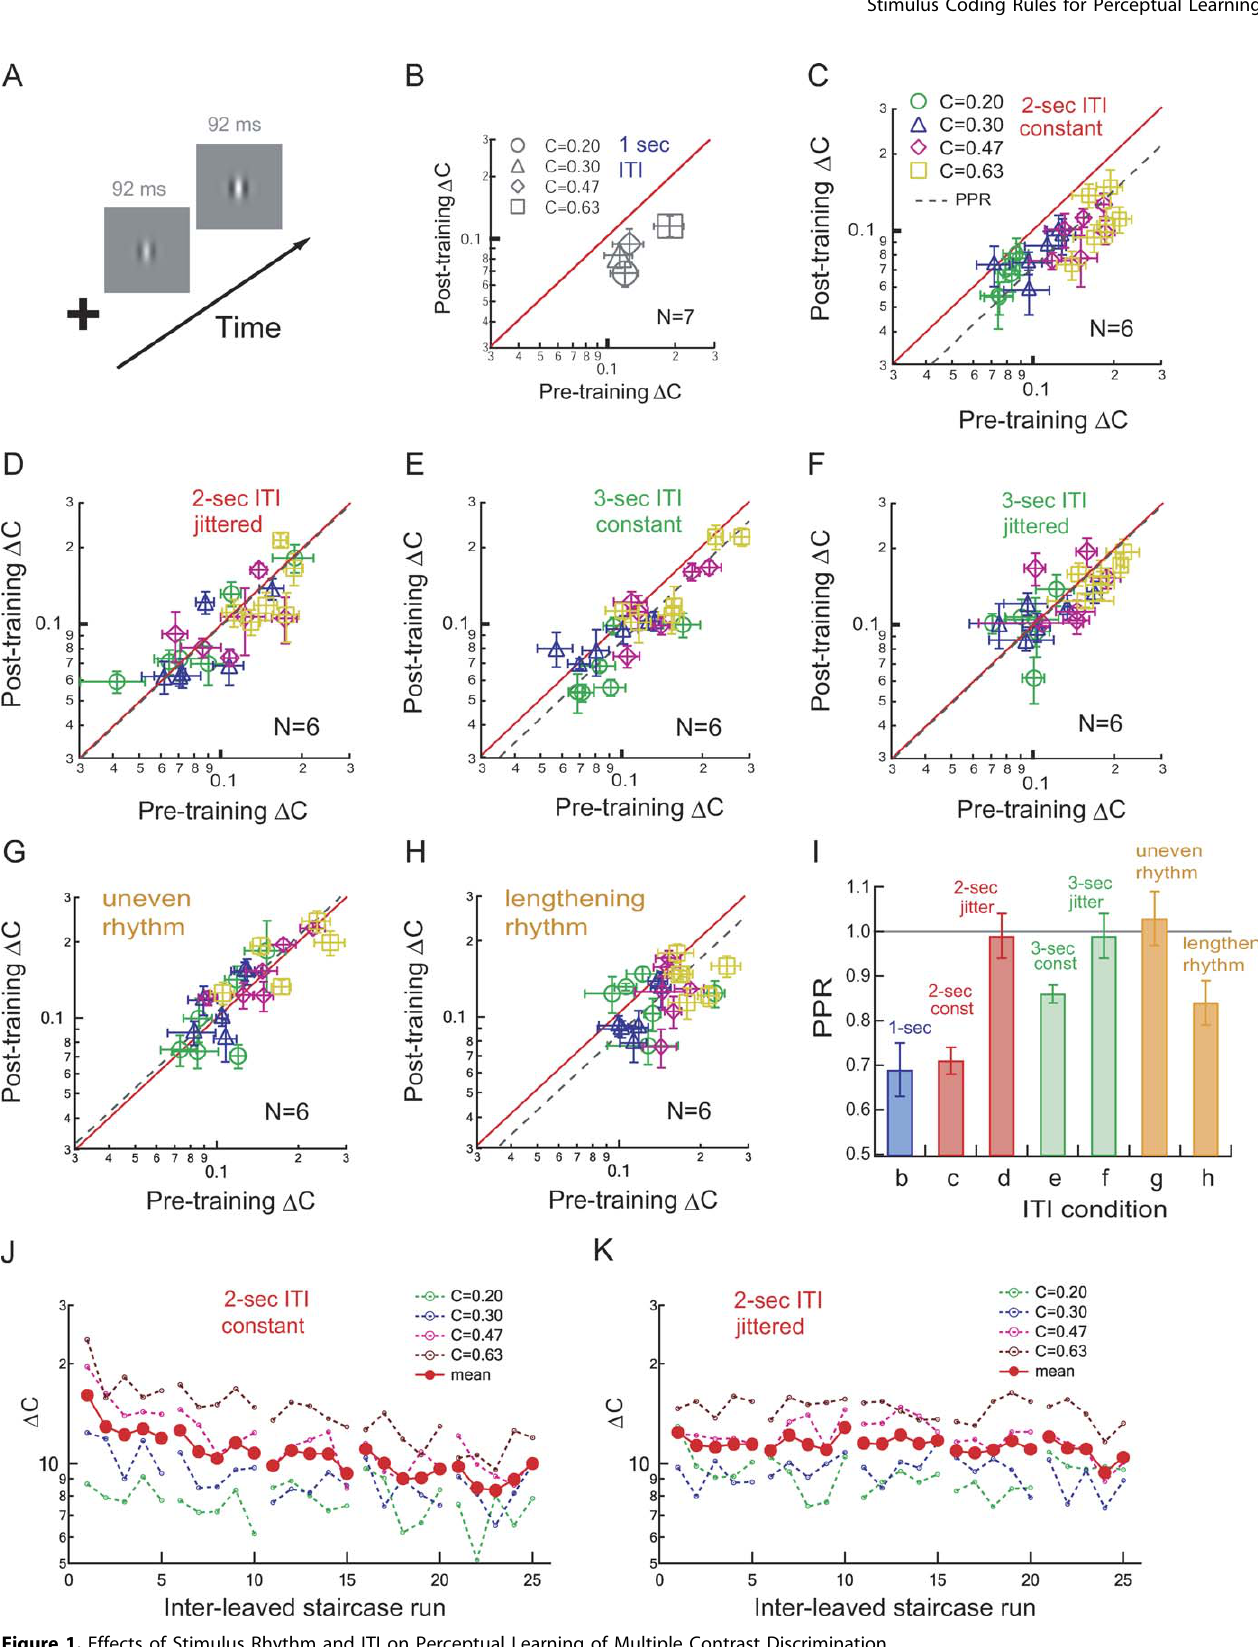
Figure 1. Effects of Stimulus Rhythm and ITI on Perceptual Learning of Multiple Contrast Discrimination (A) Illustration of a 2AFC trial in a contrast discrimination task. The observers judged which interval contained the higher contrast stimulus. (B) Learning effects under the 1-s constant ITI condition from our previous study [3]. In this and other plots throughout the paper, data points below the red diagonal lines indicate learning. Error bars indicate s.e.m. D C indicates contrast threshold. (C and D) Learning effects under 2-s constant ( F 1,5 ¼ 89.9, p , 0.001; repeated measures ANOVA) and jittered ( F 1,5 ¼ 0.08, p ¼ 0.789) ITI conditions, PLoS Biology |